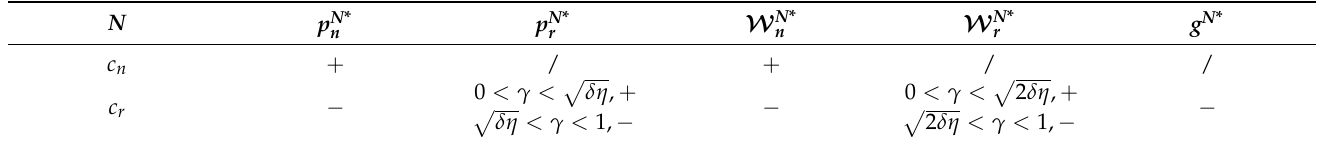
Table 3. The influence of the change in each parameter on the optimal decision under the decentral- ized decision-making model (N